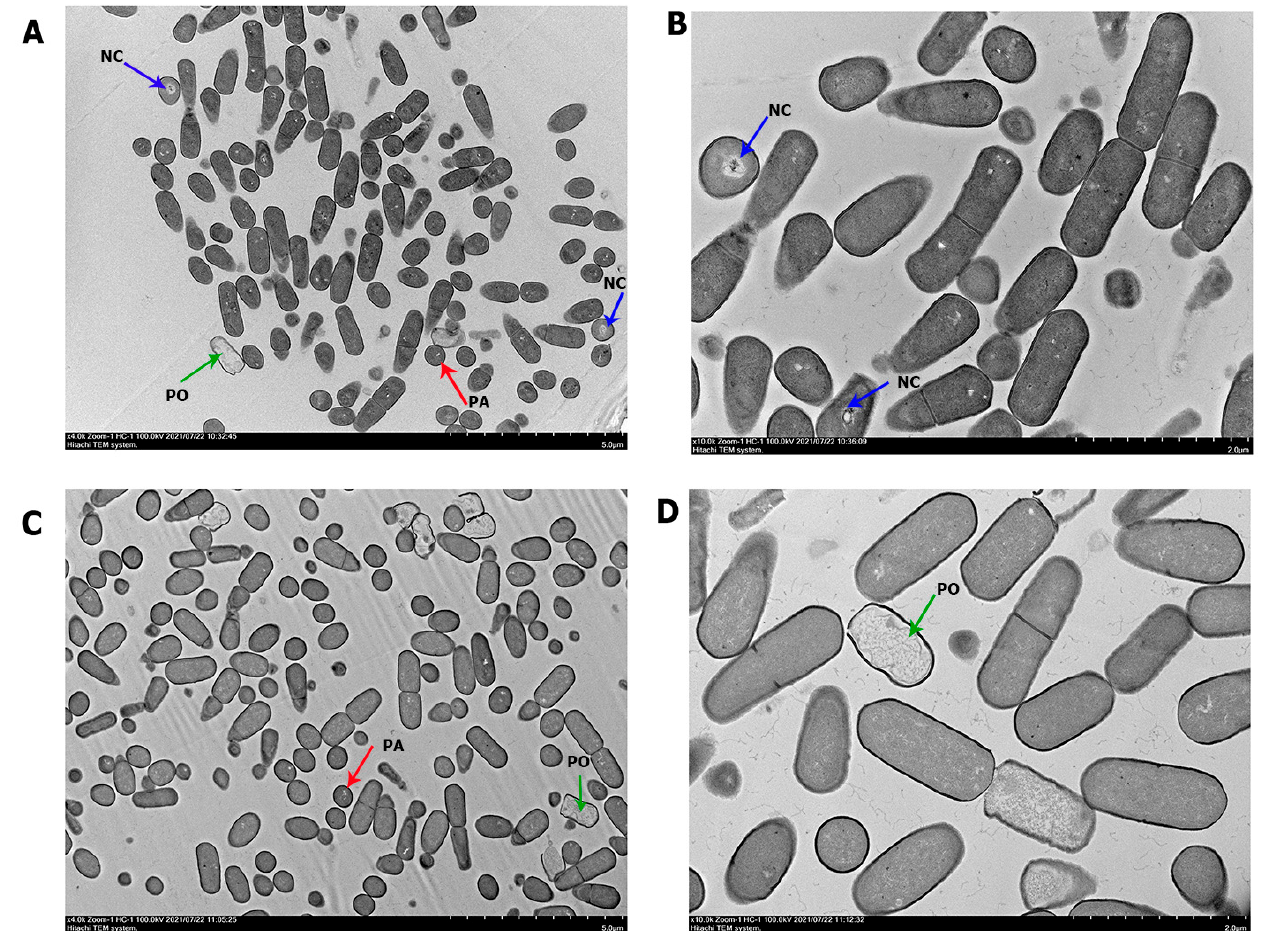
Figure 3. Transmission electron microscopy images of B. mojavensis PS17(I) ( A , B ) and B. mojavensis PS17(II) ( C , D ) under phenotypic variation. Red arrows—cell with electron-transparent inclusion cytoplasmic membrane (PA); Blue arrows—condensation of cell nucleoid (NC); green arrows—plasmolyzed cells (PO). Image scale: 5 µm ( A , C ); 2 µm ( B , D ).